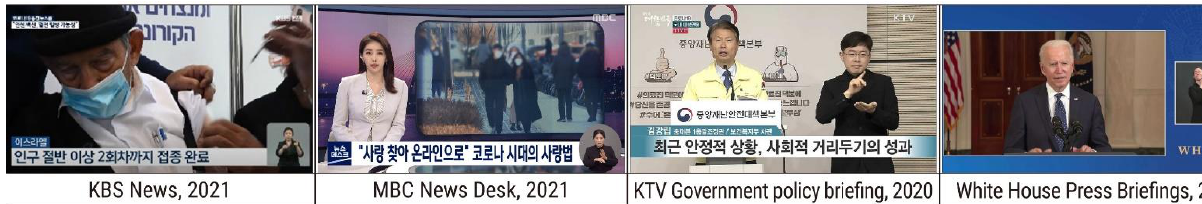
Figure 4. Example of sign language services in news.